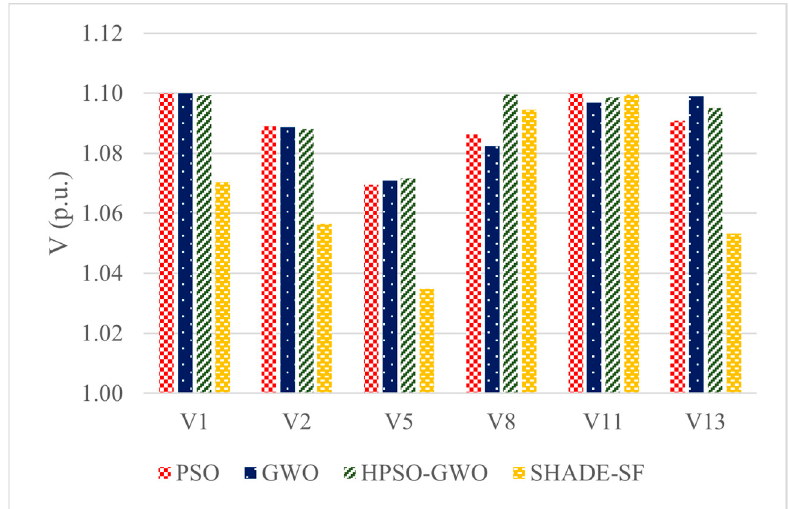
Figure 20. Generator bus voltages comparison (Case 4).